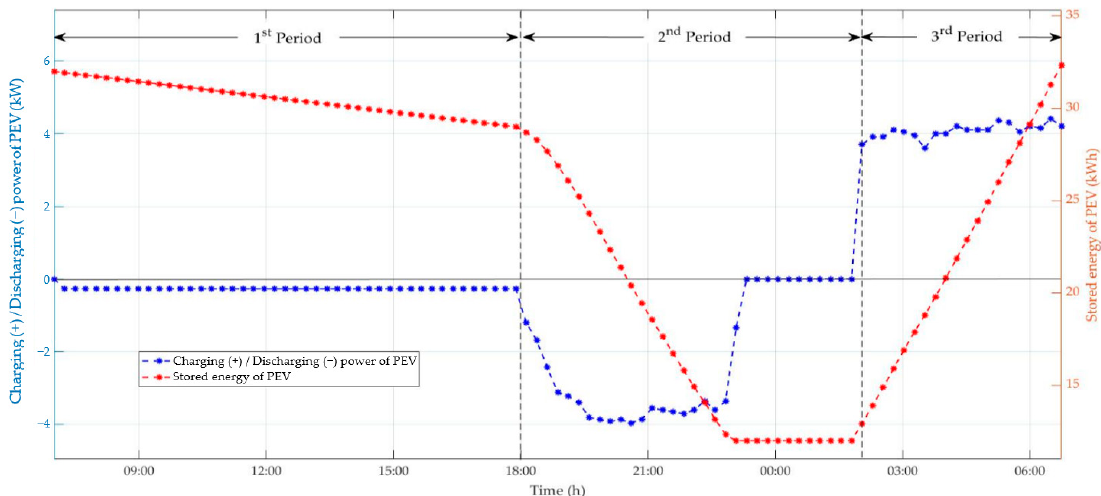
Figure 5. Energy management results of the strategy without GA when there is surplus and insufficient power in a household in each time slot.